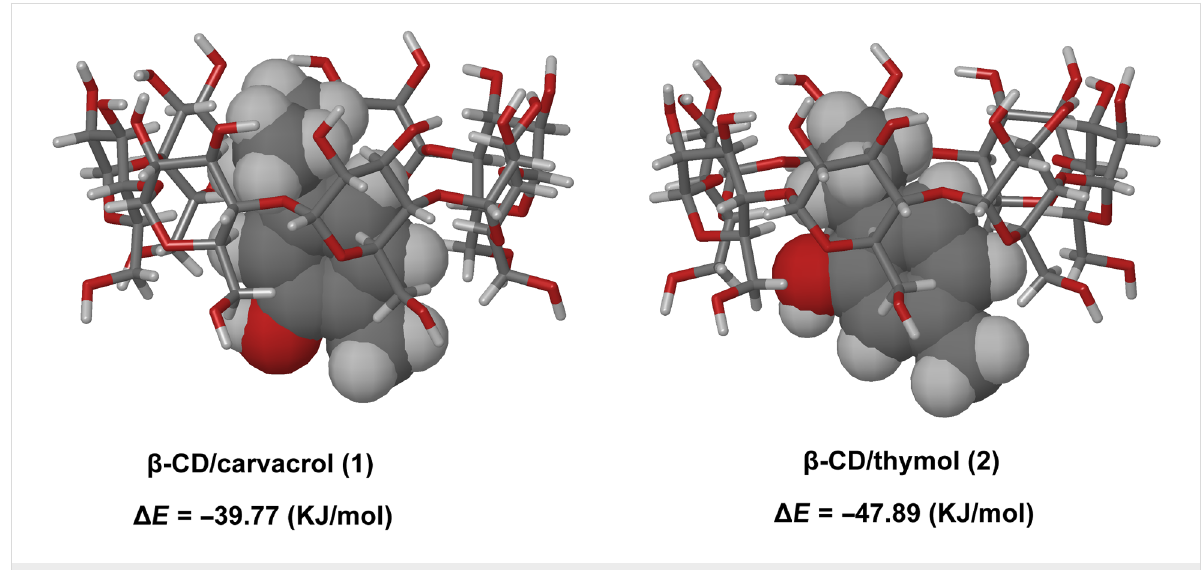
Figure 7: Representation of the most stable CD/guest inclusion complex